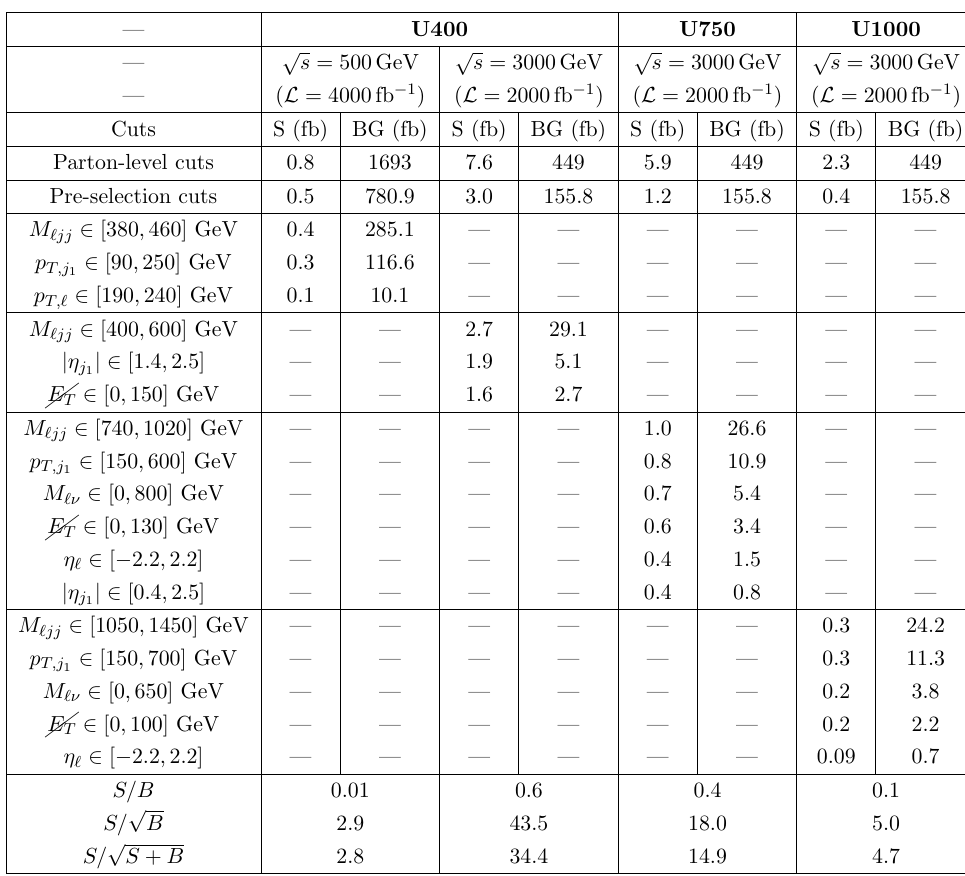
Table 10 . Cut (cid:13)ow table for uniform CW models: U400 , U750 , and U1000 . Open